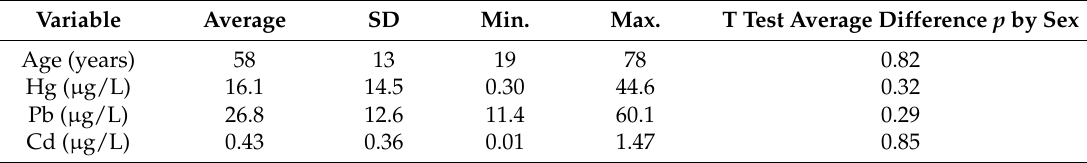
Table 1. Characteristics of the study cohort ( n = 24), 13 females, 11 males. Variable Average SD Min. Max. T Test Average Difference p by